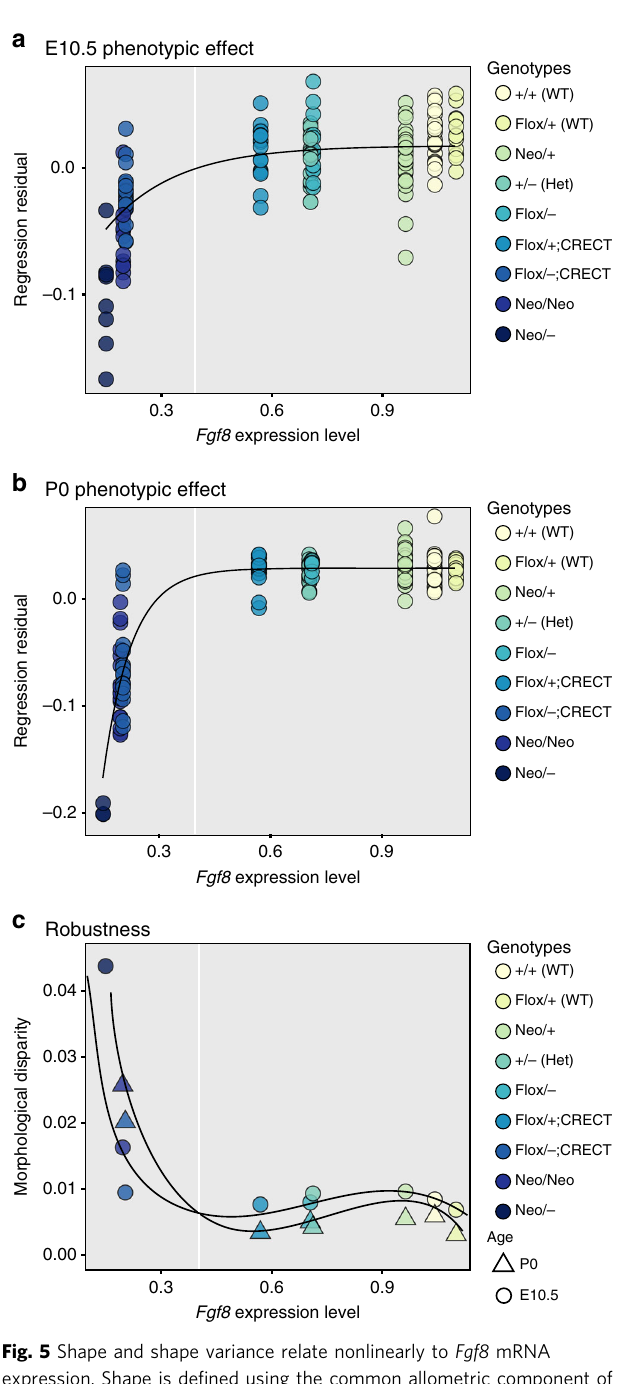
Fig. 5 Shape and shape variance relate nonlinearly to Fgf8 mRNA expression. Shape is de fi ned using the common allometric component of shape (CAC). a , b Multivariate regression of shape on Fgf8 level at a E10.5 and b P0. The black line shows the von Bertalanffy curve modeled in Fig. 4. c Variance as calculated by the Procrustes variance or morphological disparity 49,80 . The white vertical line shows an apparent threshold near 40% of wild-type Fgf8 level. P values between groups are shown